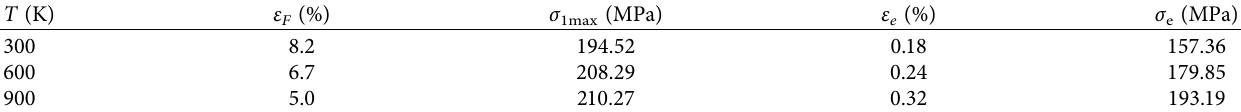
P � 0 and T � 300, 600, and 900K calculated by the SMM.